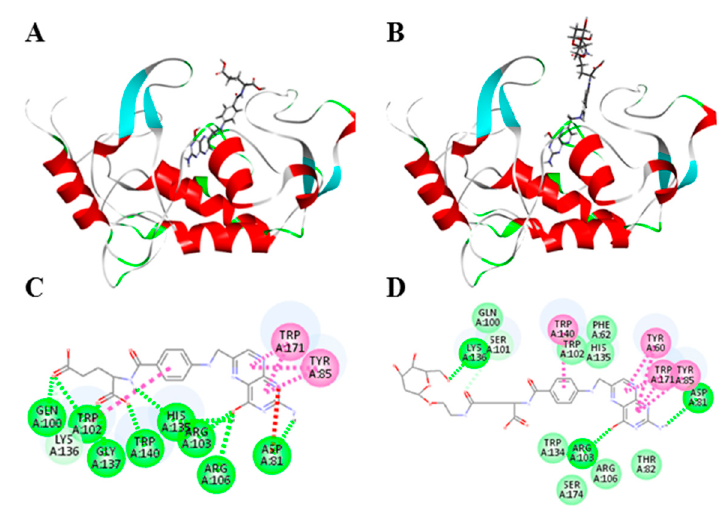
Figure 6. Docking studies of FA-2-DG with the folate receptor. ( A ) Folic acid docking into the folate receptor, red color parts represents the alpha helix in the protein structure, light blue color parts represents the beta folding; ( B ) FA-2-DG docking into the folate receptor, red color parts represents the alpha helix in the protein structure, light blue color parts represents the beta folding; ( C ) the 2-D diagram of ligand – receptor interactions between folic acid and the folate receptor; ( D ) 2-D diagram of ligand – receptor interactions between FA-2-DG and the folate receptor.